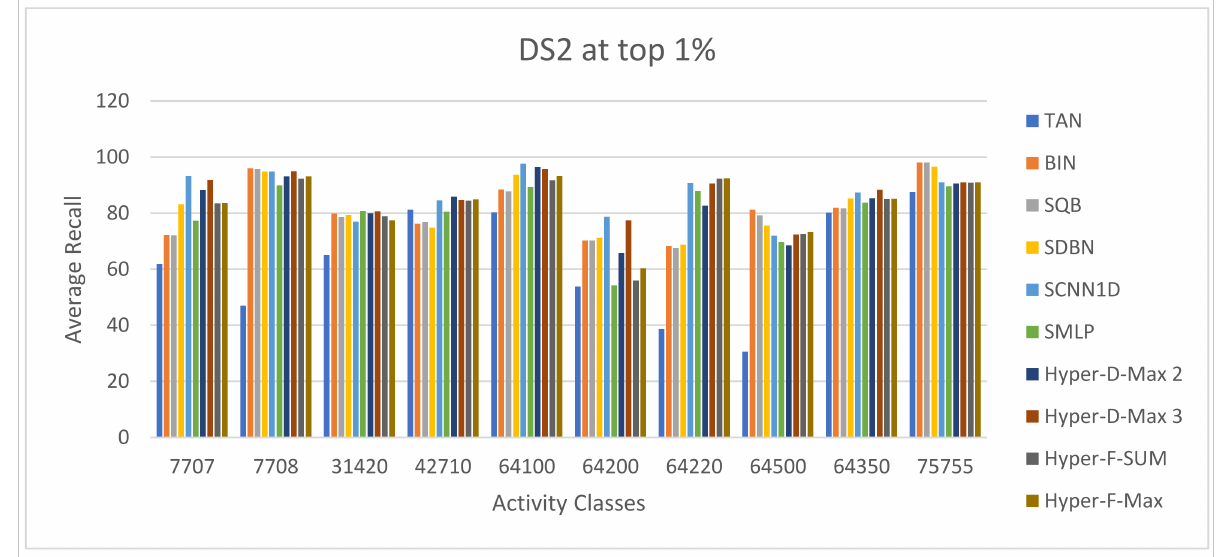
Figure 10. The comparison among methods for the average recall percentage at the top 1% in MDDR-DS2 (homogeneous). Table 8. Top 5% retrieval recall for MDDR-DS2 (structurally homogeneous) dataset for descriptor (ECFC